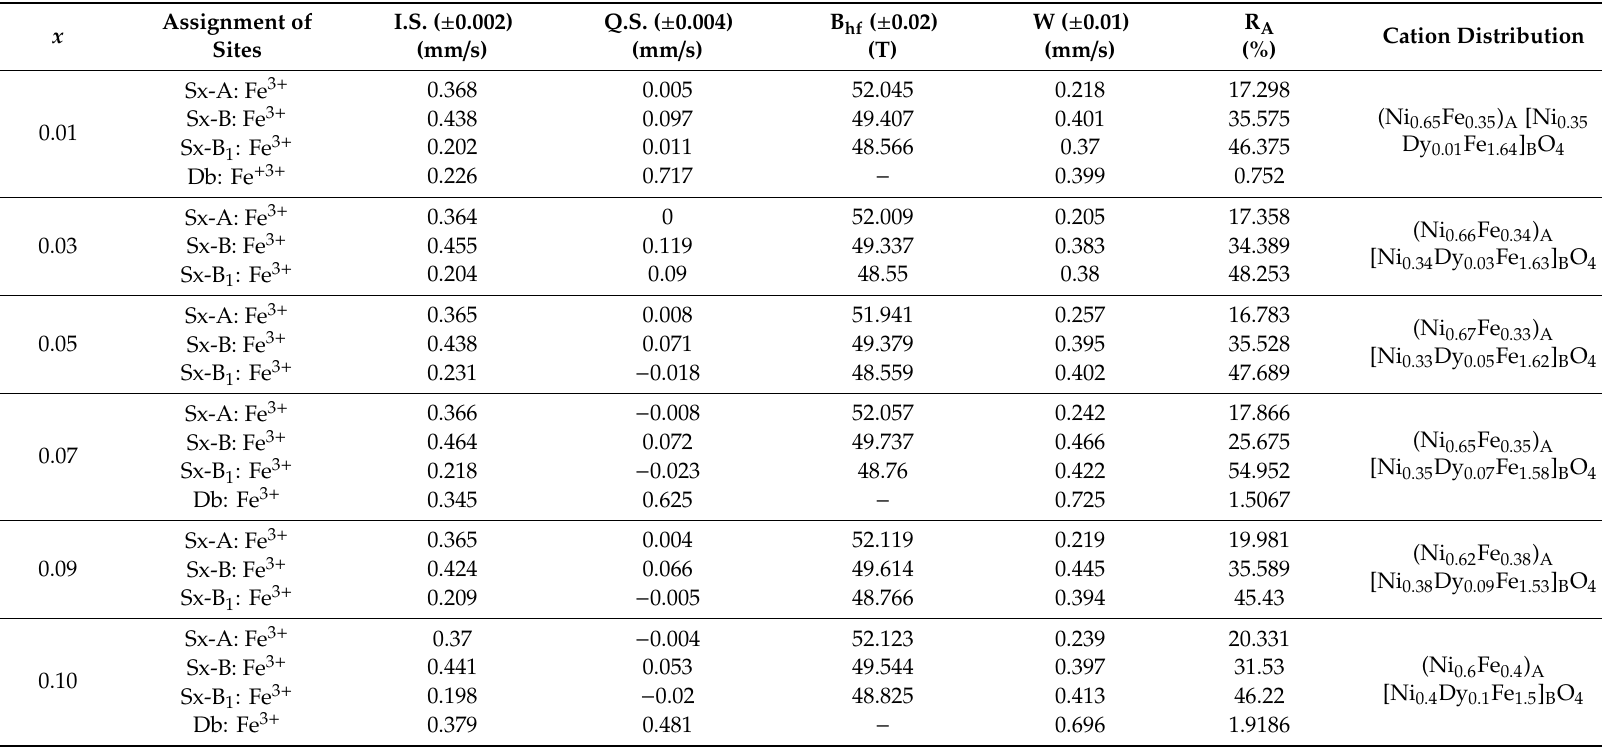
Table 2. Evaluated Mössbauer parameters of studied ferrite NPs (B hf : hyperfine magnetic field, I.S.: isomer shift, Q.S.: quadrupole splitting, W: line width, and R A : Relative